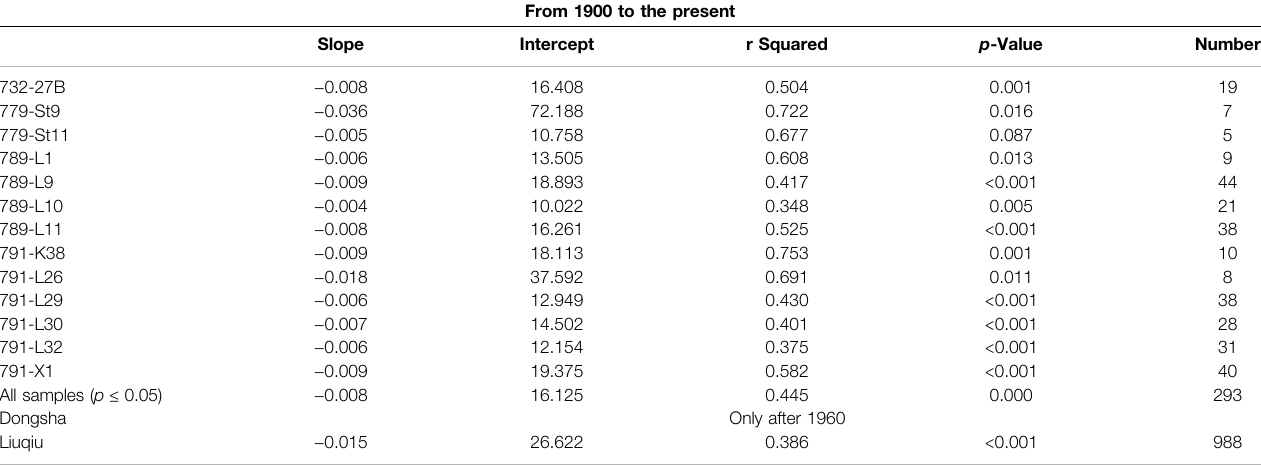
TABLE 2 | Linear regression analyses of δ 13 C from 1900 to the present.